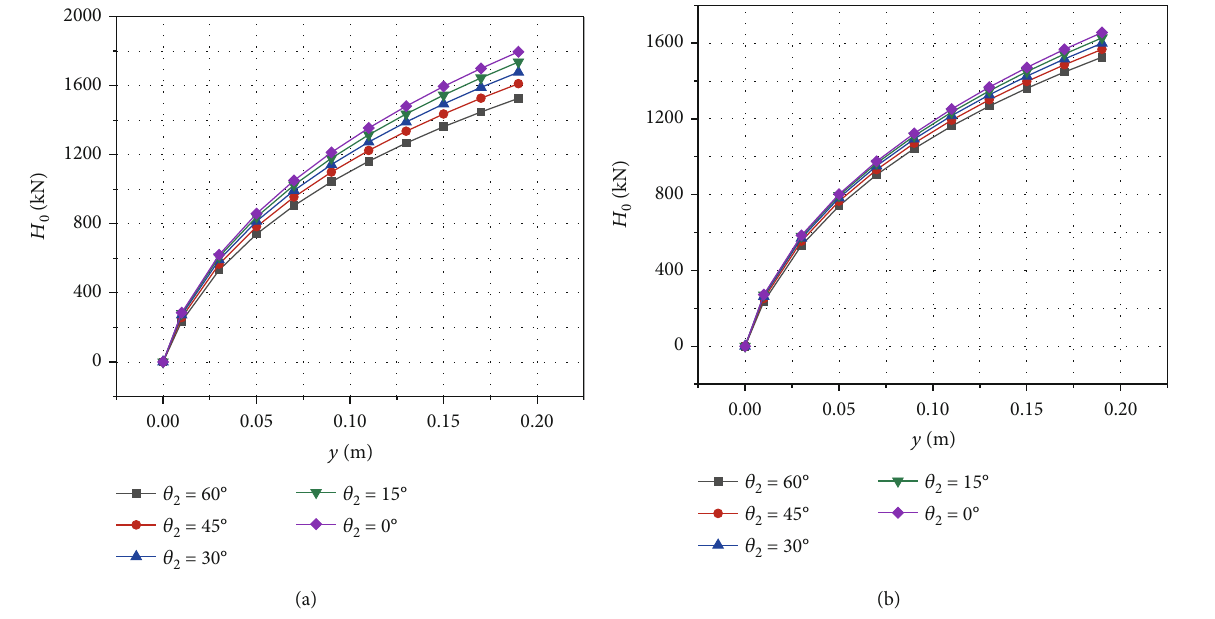
Figure 17: E ff ect of θ